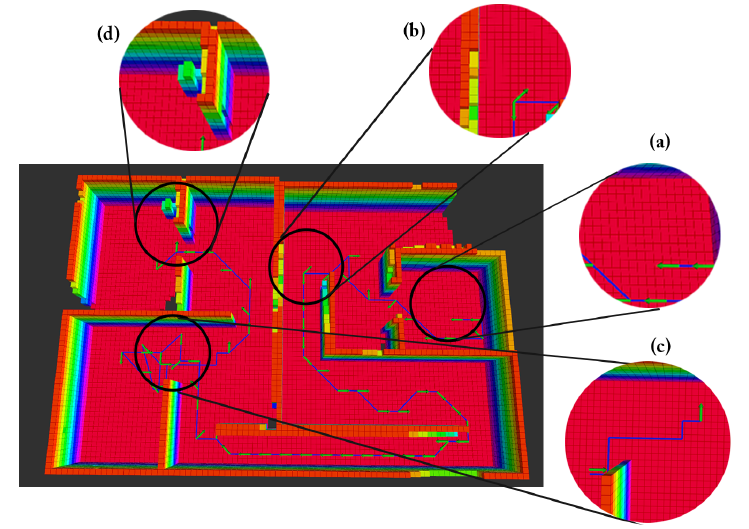
Figure 16. Vehicle traversed path in the U 3 -merged test using AGSA where ( a ) start location, ( b ) direct-path trajectory, ( c ) location of the detected local minimum where A* Planner was invoked to generate path, ( d ) end